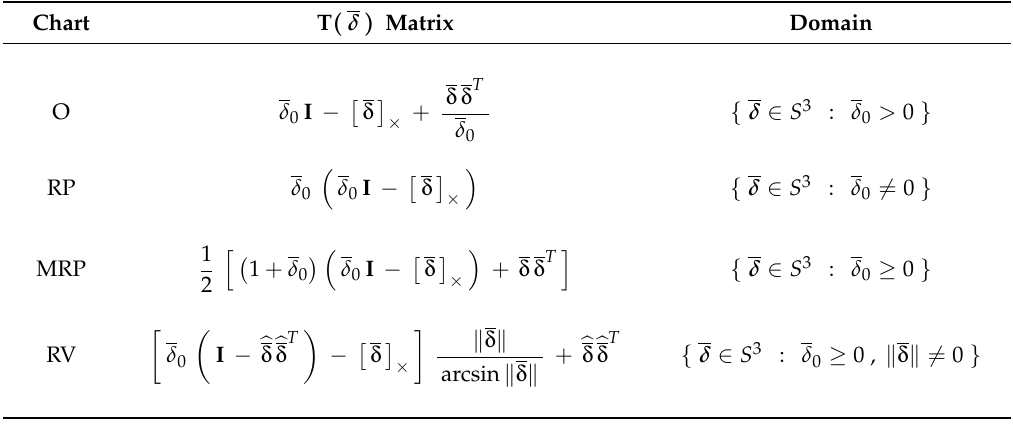
Table 4. T -matrices for the transition maps of the charts